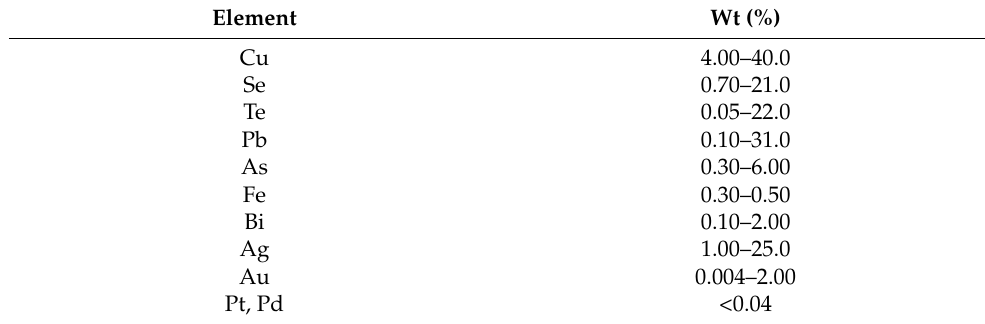
Table 1. Typical chemical composition of anodes slimes